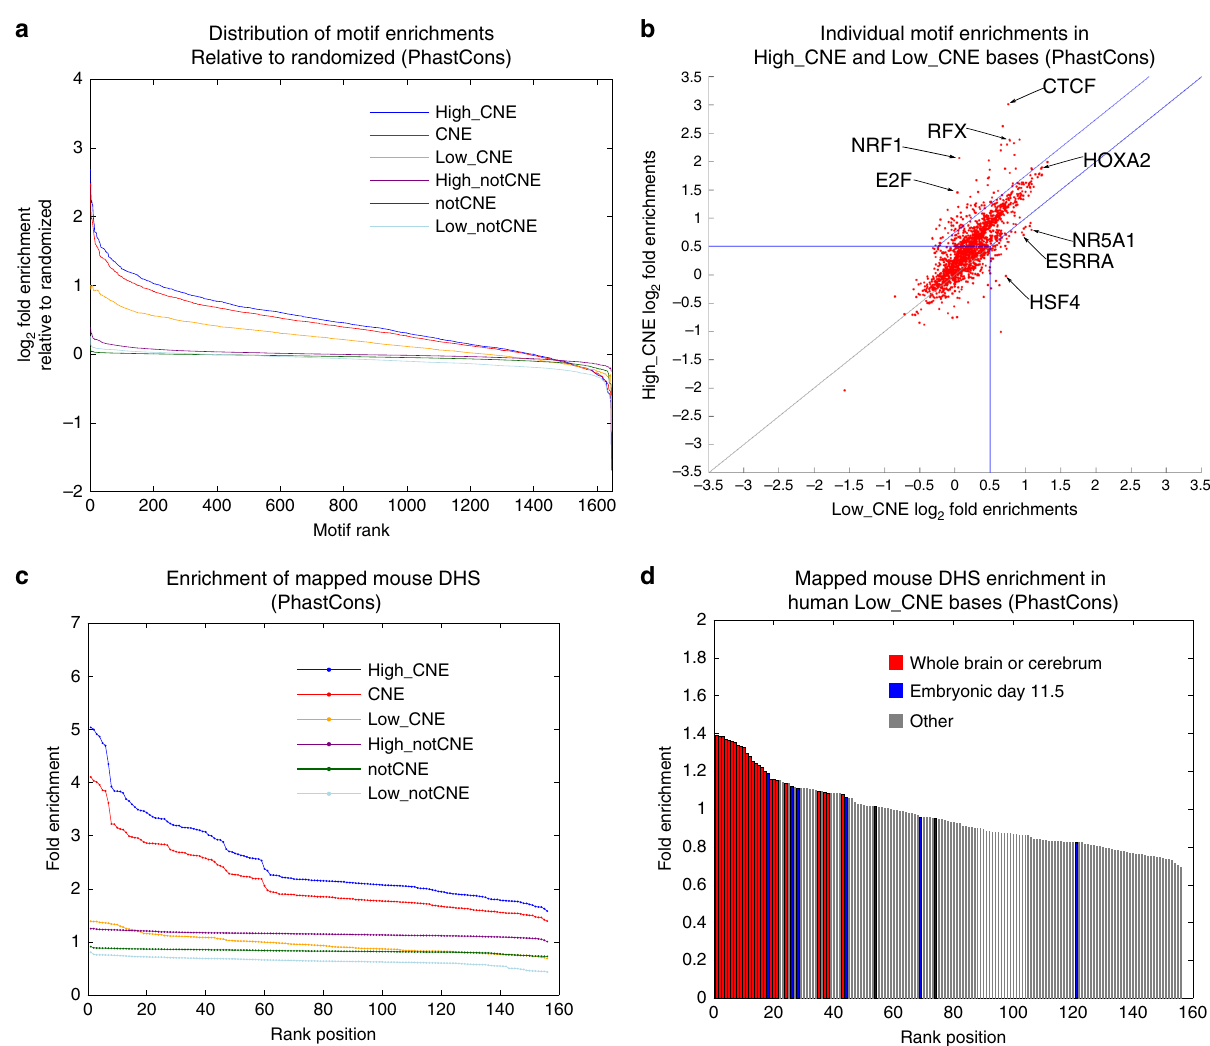
Fig. 4 CNEP score ’ s relationship to TF sequence motifs and DHS in mouse. a The plot shows the difference of the distribution of motif enrichments relative to the distribution for a randomized set of the motifs for the PhastCons High_CNE, CNE, Low_CNE, High_notCNE, notCNE, and Low_notCNE bases. The x -axis is the rank position of the motif among the 1646 motifs. The y -axis is the difference between the log 2 fold enrichment based on the actual motif calls and the median log 2 fold enrichment from three randomized versions at the same rank position (see “ Methods ” section). Similar plots for other constrained elements can be found in Supplementary Fig. 15 and at other thresholds for de fi ning notCNE high bases in Supplementary Fig. 16. b Scatter plot of individual motif enrichments. The x and y axes corresponds to the log 2 fold enrichments in PhastCons Low_CNE and High_CNE bases, respectively. The blue lines separate the three regions used for the GO-enrichment analysis, ‘ High_CNE strongly preferred ’ , ‘ High_CNE moderately preferred ’ , and ‘ Low_CNE preferred ’ , where at least one of the Low_CNE or the High_CNE log 2 enrichment is ≥ 0.5 (Supplementary Data 3 and 4). The gray line is the y = x line where both Low_CNE and High_CNE log 2 enrichments are <0.5. Similar plots based on other thresholds of the CNEP score can be found in Supplementary Fig. 17. Selected motifs are labeled. c The distribution of enrichments for DHS from 156 experiments in mouse, where the sites are mapped to human and enrichments are computed relative to enrichments for randomized DHS, for PhastCons High_CNE, CNE, Low_CNE, High_notCNE, notCNE, and Low_notCNE bases (see “ Methods ” section). Similar plots for other constrained elements can be found in Supplementary Fig. 18. d A bar graph corresponding to the enrichments shown in c for Low_CNE bases. Bars are colored to indicate if the experiment is of whole brain or cerebrum, embryonic day 11.5, or neither. Similar plots for other constrained elements can be found in Supplementary Fig. 19. A full set of enrichment values can be found in Supplementary Data 5. Source data are provided as a Source Data fi